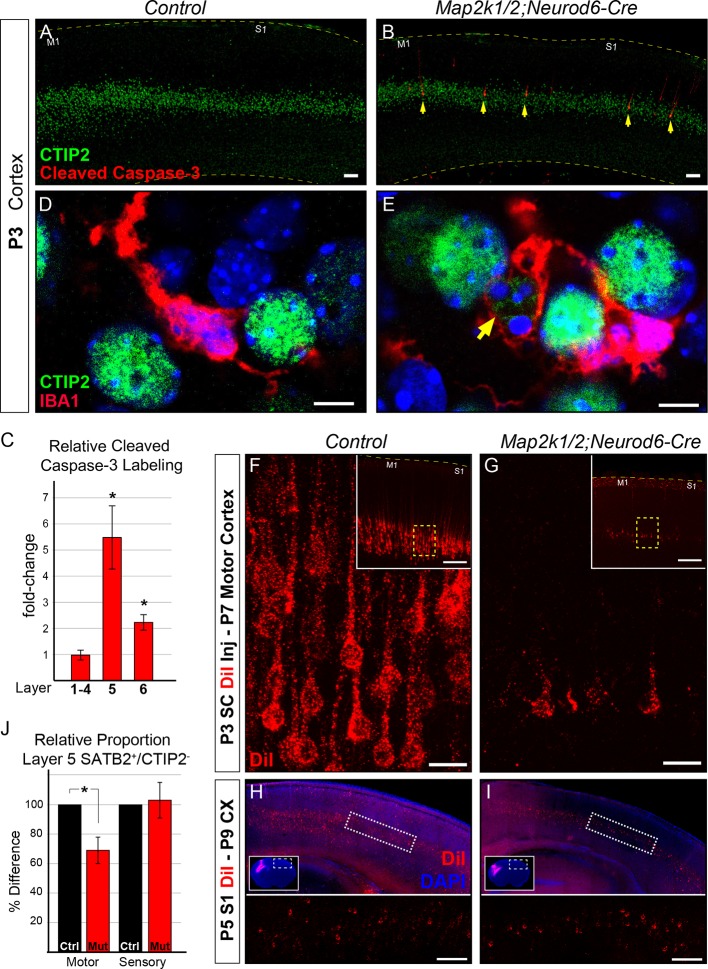
Initiation of layer 5 neuron death by P3 in Map2k1/2;Neurod6-Cre mutants.(A–B) Representative confocal images of immunolabeling for cleaved activated caspase-3, a well-known marker of neuronal apoptosis in P3 control (A) and Map2k1/2;Neurod6-Cre (B) sensorimotor cortices. Note the extensive increase in the number of activated caspase-3+ cells co-labeled with CTIP2 in layer 5 of mutant cortices (B, yellow arrows) (n=4, scale bar=50 µm). (C) Quantification of activated caspase-3+ cells in upper layers (layer 1–4), layer 5 (CTIP2+) and layer 6 revealed a pronounced elevation in the number of apoptotic cells in layer 5 in P3 Map2k1/2;Neurod6-Cre mice relative to controls. The numbers of activated caspase-3+ cells are comparable in upper layers and doubled in layer 6 relative to controls. (n=4, mean ± SEM, * p<0.05) D-E. Relative to controls (D), many microglia (IBA1+) were observed with processes surrounding CTIP2 labeled neurons in layer 5 of mutant cortices (E) (n=3, scale bar=5 µm). F-G. Retrograde labeling of corticospinal neurons at P3 via DiI injection into the cervical spinal cord revealed a substantial reduction in the number of DiI labeled neuronal bodies in mutant (G) sensorimotor cortices at P7 when compared to controls (F) (n=3, scale bar=20 µm). (H–I) Retrograde labeling of layer 5 neurons that project into the contralateral hemisphere by injection of DiI in contralateral cortices, did not reveal an obvious loss in mutant (I) mice when compared to controls (H) (n=3, scale bar=100 um). (J) Quantification of the relative number of layer 5 SATB2+/CTIP2- neurons as a proportion of the total number of NEUN+ neurons in a cortical column revealed a substantial decrease in motor, but not sensory, cortices in mutant mice (n=3, mean ± SEM, *p=0.003).